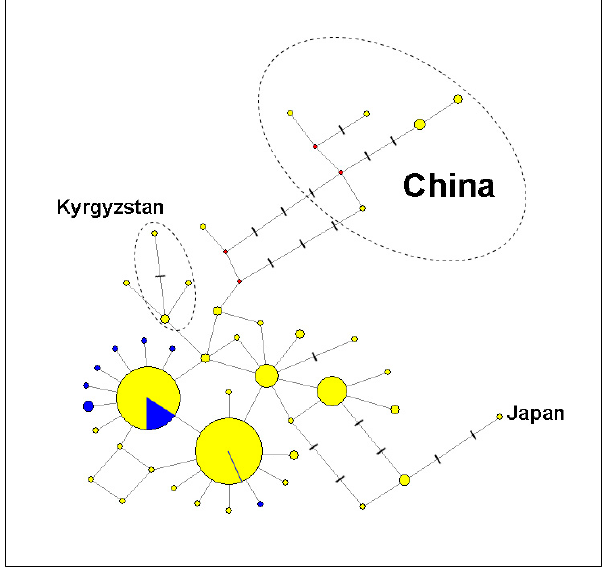
Figure 2. Aglais urticae COI haplotype network. Yellow circles: GenBank data; blue circles: sequences obtained in this study. The circle diameter is proportional to the number of individuals; red dots stand for missing haplotypes; hatches indicate mutation steps.